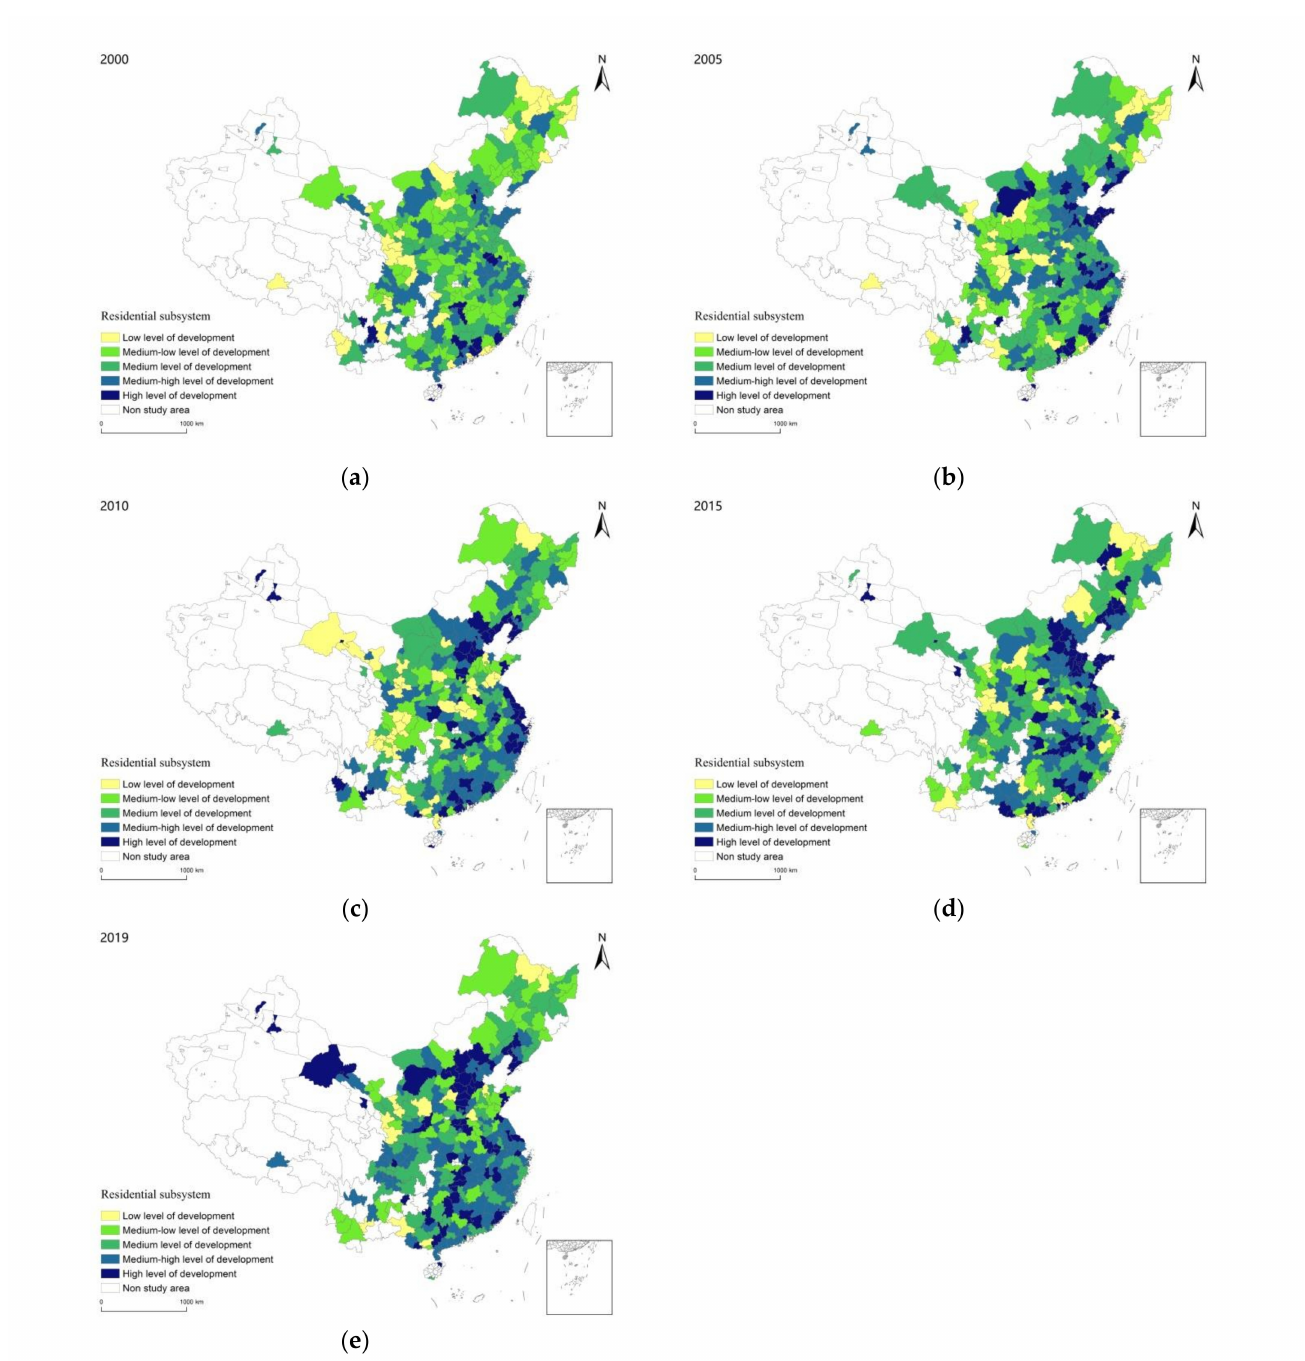
Figure 4. Spatial distribution map of the sustainable development level of the residential system of urban human settlements in China. ( a ) 2000; ( b ) 2005; ( c ) 2010; ( d ) 2015; and ( e )